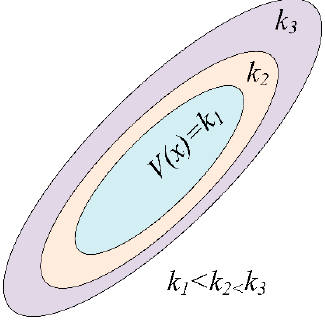
Figure 8. A Lyapunov function’s level surfaces.